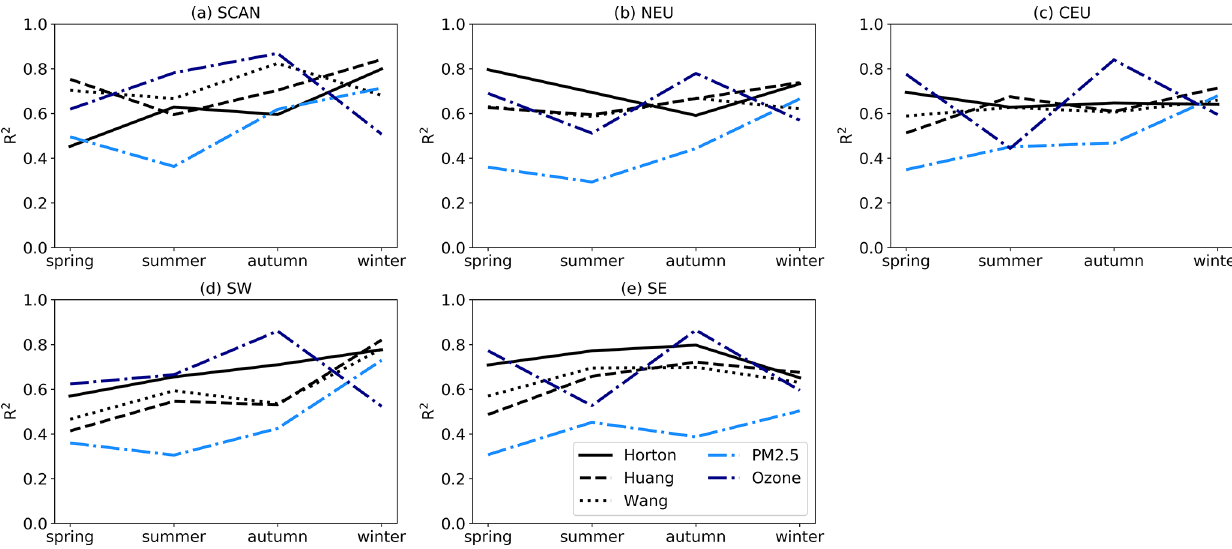
Figure 9. Stepwise multiple linear model skill in (a) SCAN, (b) NEU, (c) CEU, (d) SW and (e) SE for stagnation as defined using the Horton (solid), Huang (dashed) and Wang (dotted) indices and pollutants PM 2 . 5 (light blue) and ozone (dark blue) during the period 2003–2018.